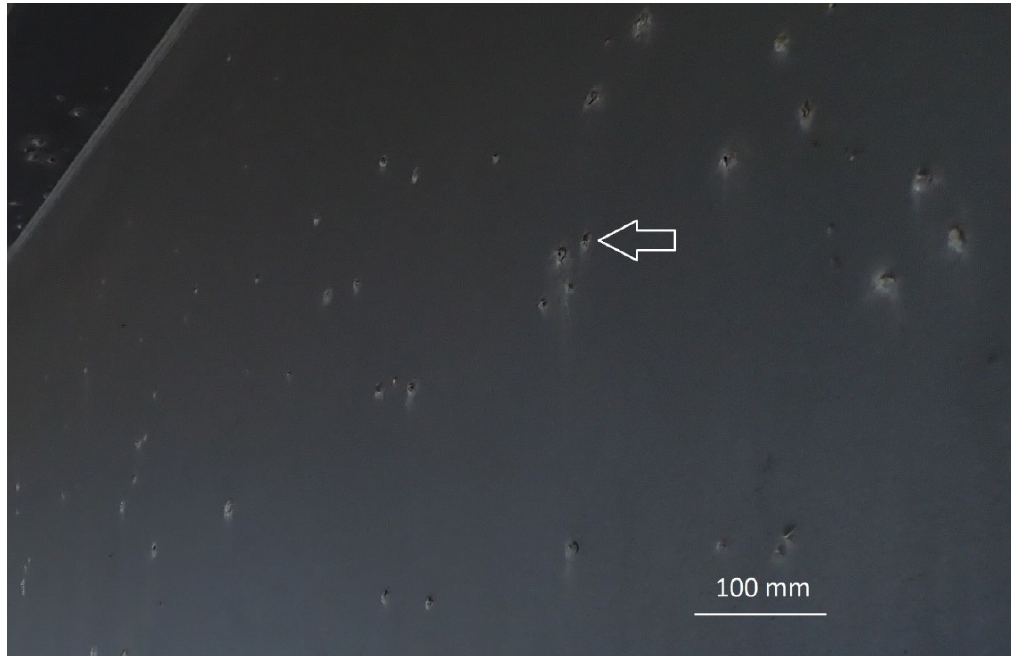
Figure 6. The corrosion of the TSZ due to “spitting” during thermal spraying. All the protrusions in the coating, one of them marked with an arrow, is due to spitting during thermal spraying. The paint film is too thin over the zinc protrusions and the zinc starts to corrode. Photo: NPRA. The fourth failure mechanism is the hydrolysis of the alkyd paint in contact with concrete. The ester bonds in the alkyd binder are broken when exposed to an alkaline environment. This is also called saponification and is a well-known degradation mechanism for alkyds [14]. This was typically found on the upper flange of H-beams carrying a concrete bridgeway, see Figure